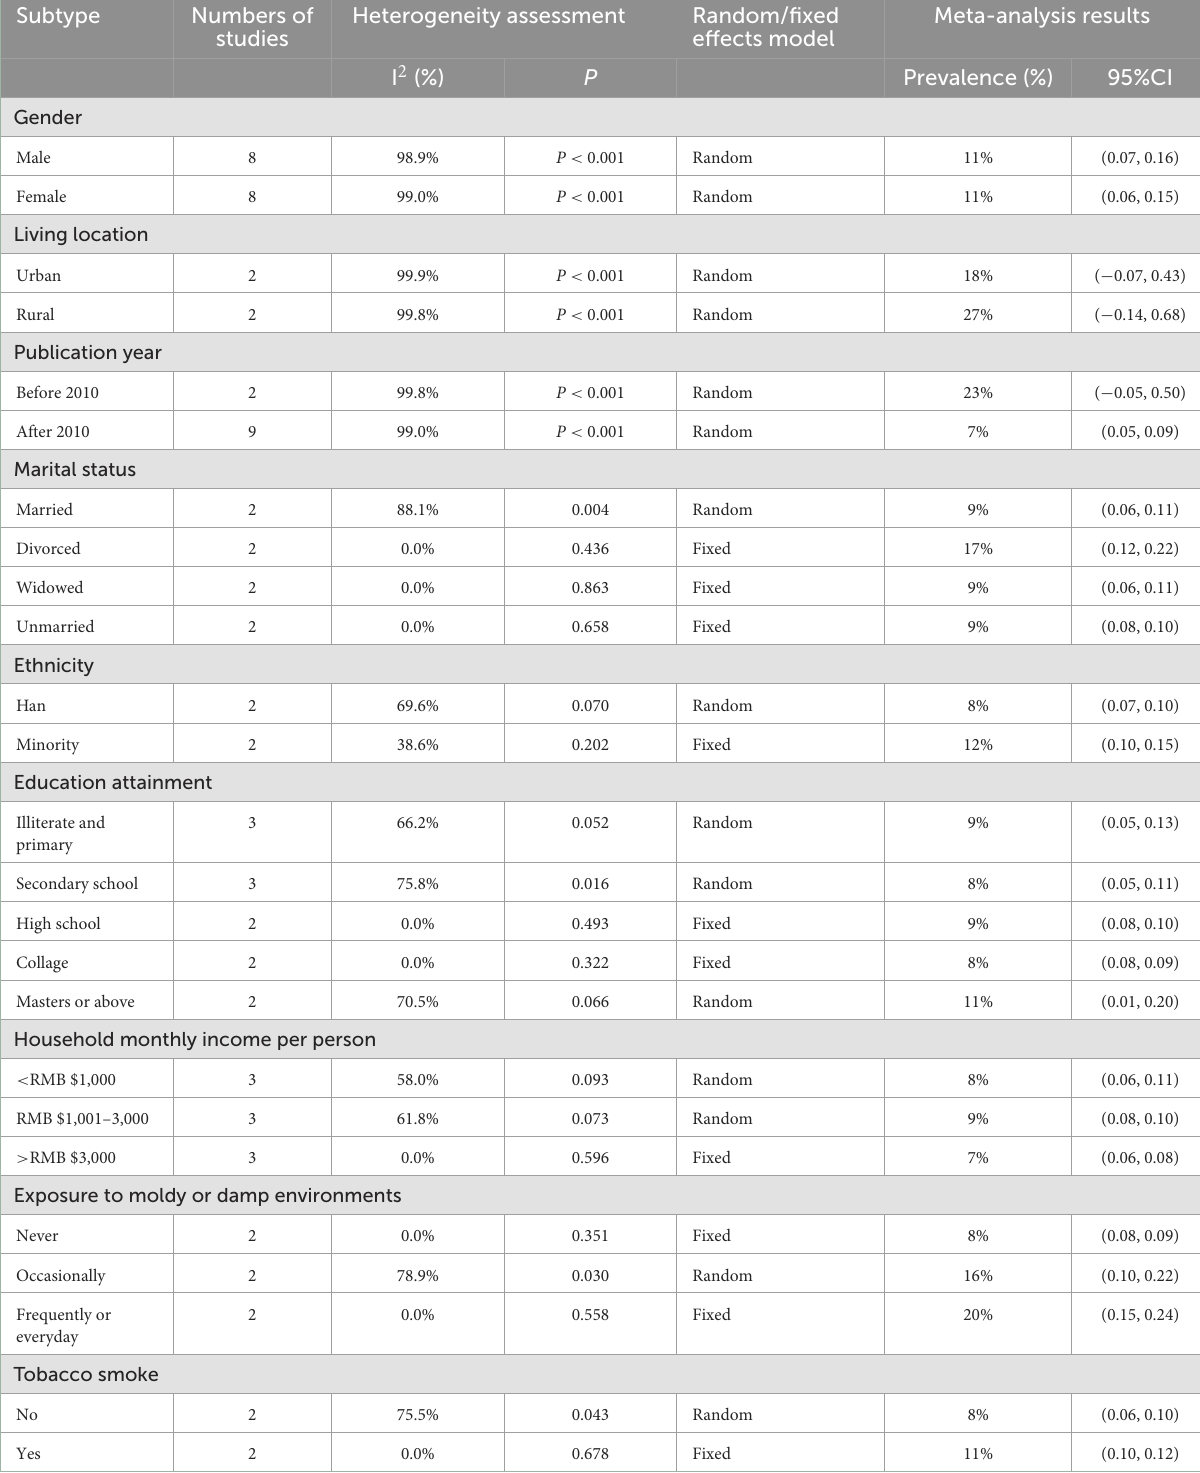
TABLE 2 Different subgroup analyses in the prevalence of CRS among